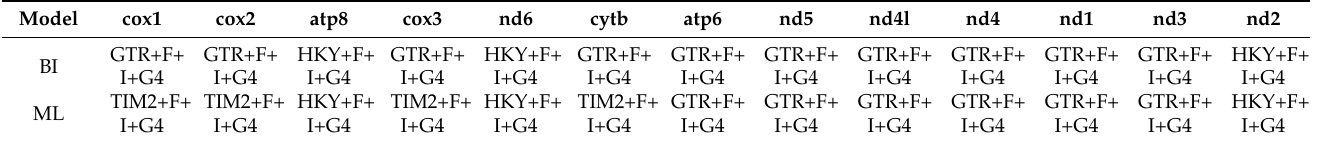
Table 3. Best fit models for BI and ML analysis on dataset